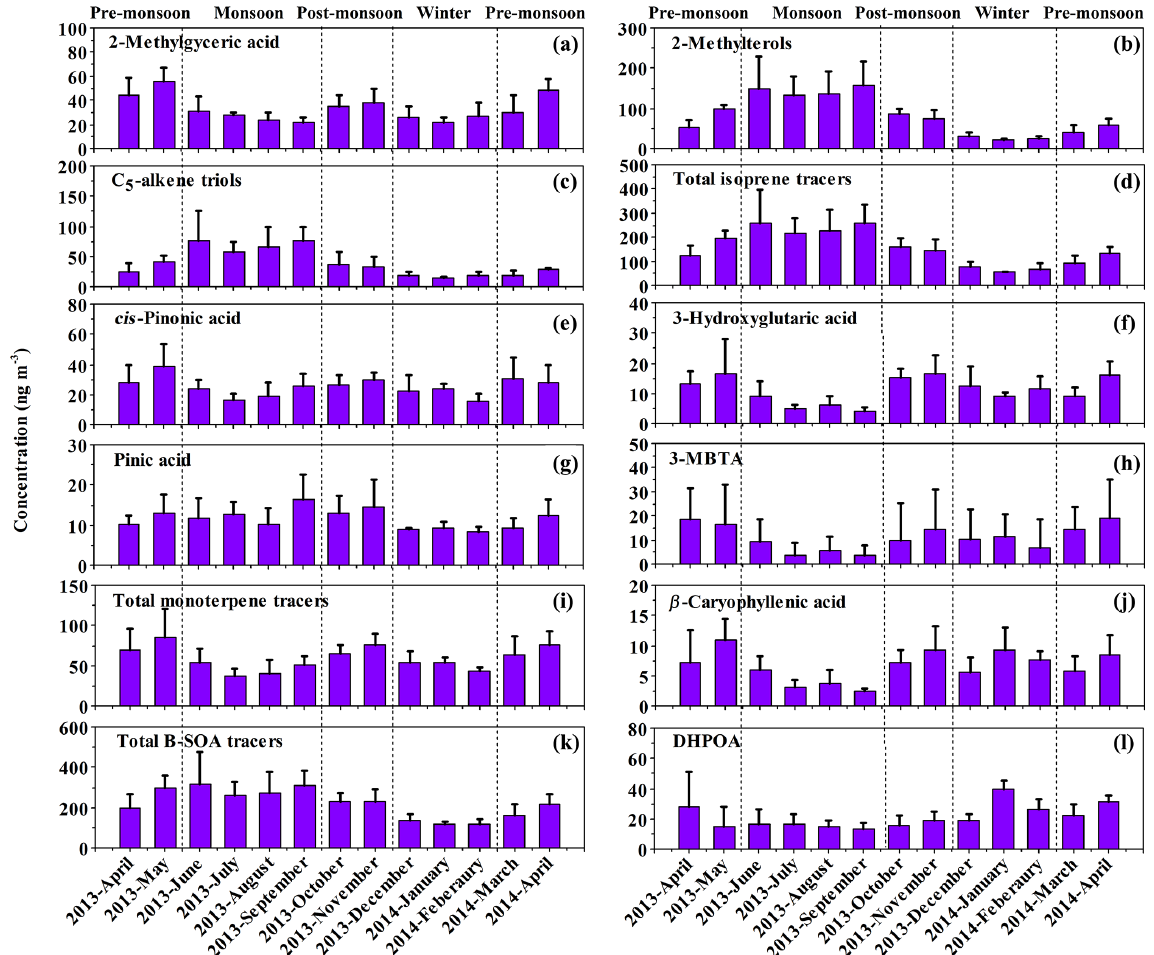
Figure 5. Monthly variations in B-SOA tracers, total isoprene tracers, total monoterpene tracers, β -caryophyllenic acid, total B-SOA tracers, and DHOPA at the Bode site, Kathmandu Valley, during April 2013–April